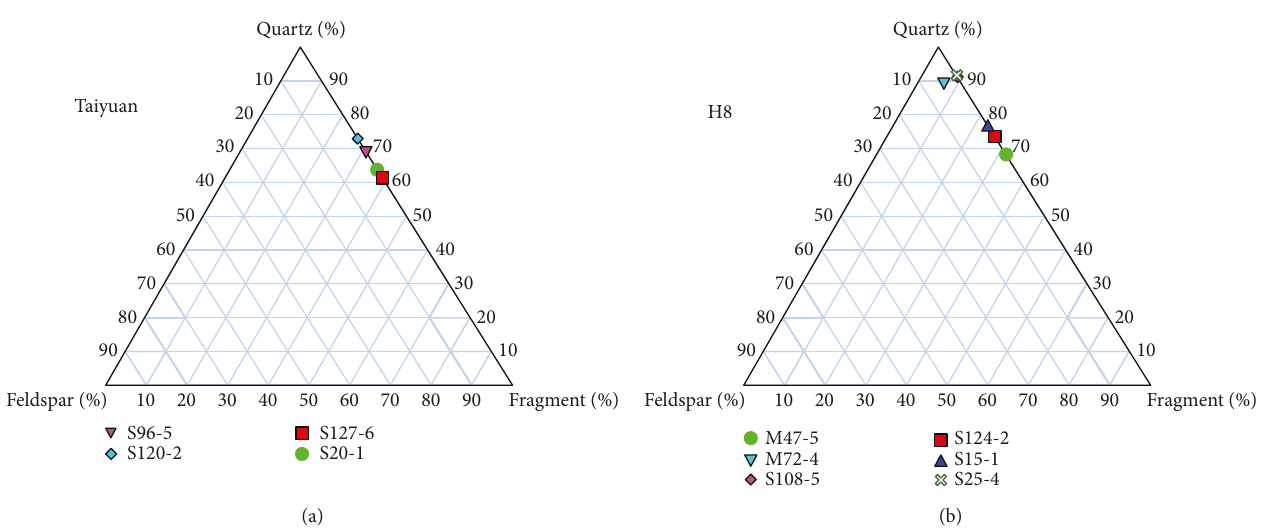
Figure 3: The mineral composition of samples: (a) Taiyuan formation; (b) H8